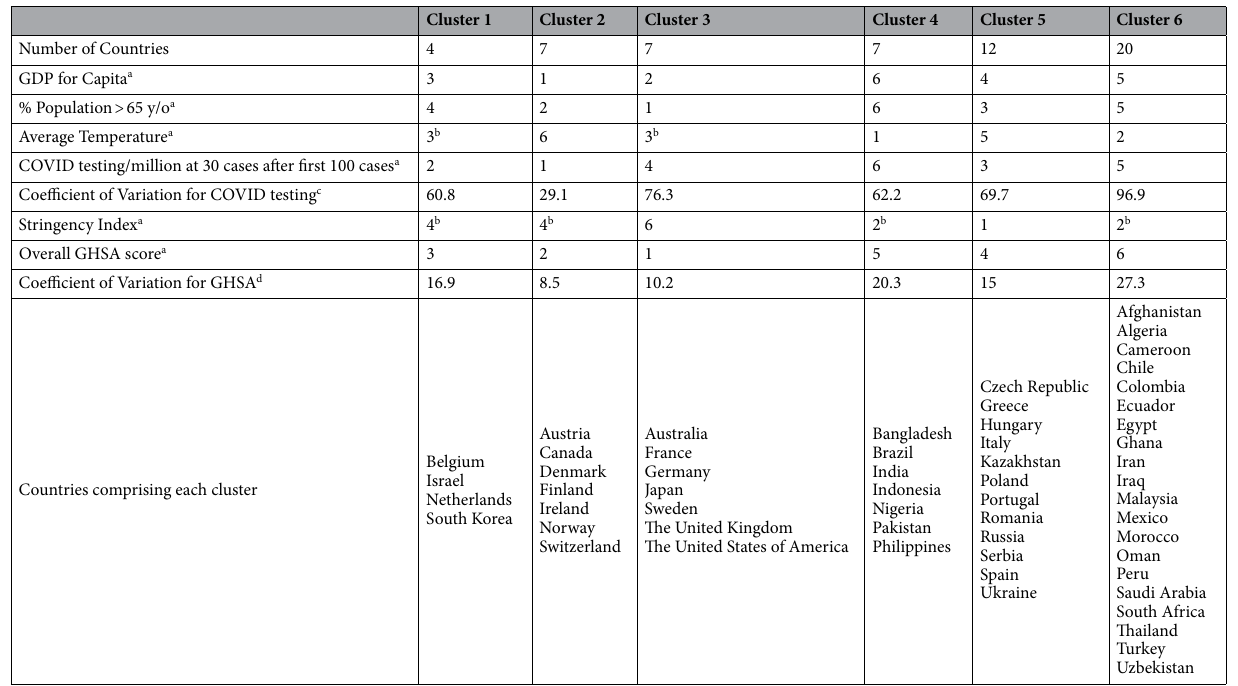
Table 1. Simplified composition of 6 clusters included for analysis. a Ranked 1–6, highest to lowest. b Represents tie in a category. c Coefficient of variation for the population Covid Testing/Million (30 days after 100 cases) was 103.5. Variation is lower in the clusters than the general population. d Coefficient of variation for the population GHSA was 26.1. For all but cluster 6, there is less variation in the clusters than the